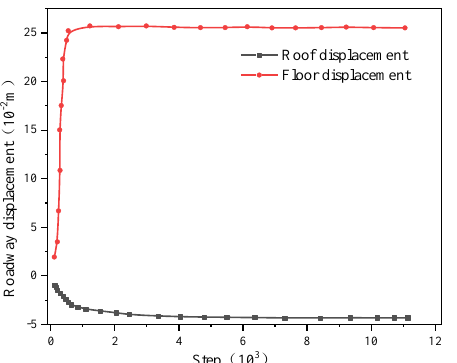
the roadway 60 m.